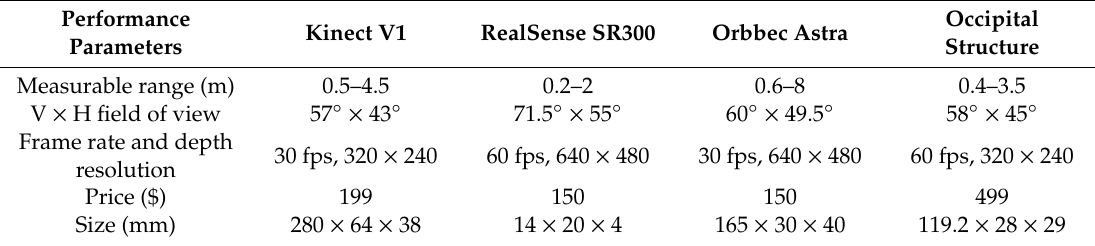
Table 6. Depth camera comparison based on structured